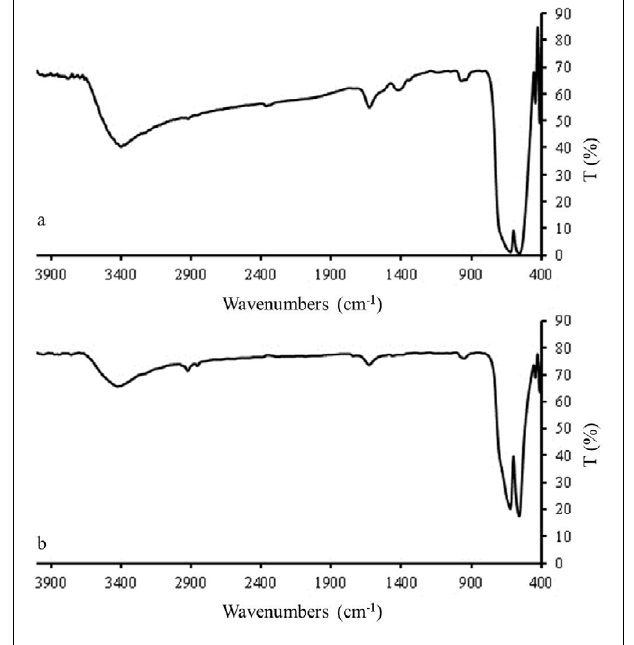
O nanoparticles at a) 500 ºC and b) 600 ºC 2 3